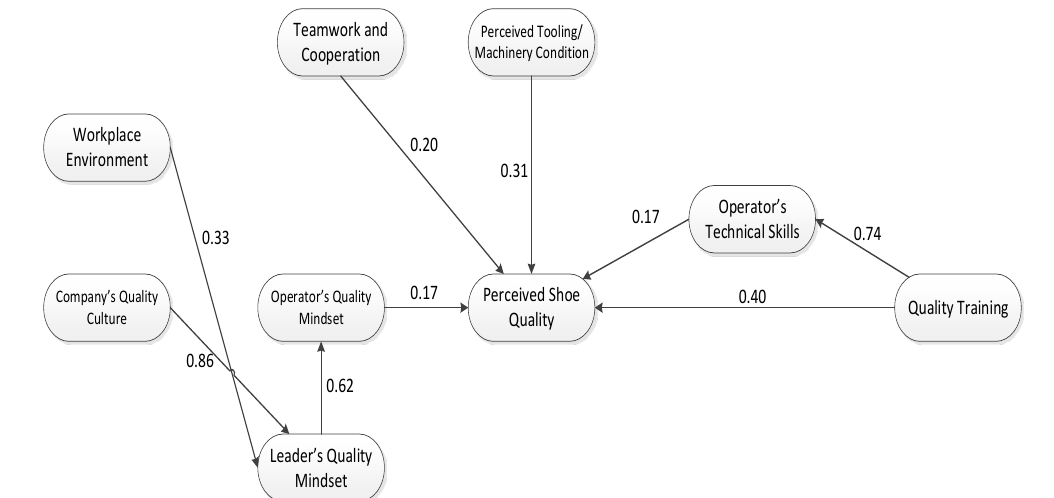
Figure 3. The final SEM for evaluating factors affecting the perceived product quality in the shoe manufacturing industry.